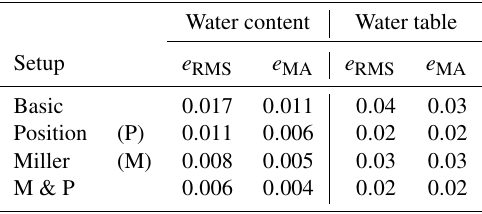
Table 6. For each setup of the 2-D study, the results are bench- marked with statistical measures. Similar to the 1-D study, estimat- ing the sensor position and the Miller scaling factors improves the statistical measures related to the water content significantly. The statistical measures for the position of the groundwater table in- cluding both the tensiometer and the groundwater well data improve only for setups in which the sensor positions are estimated. Water content